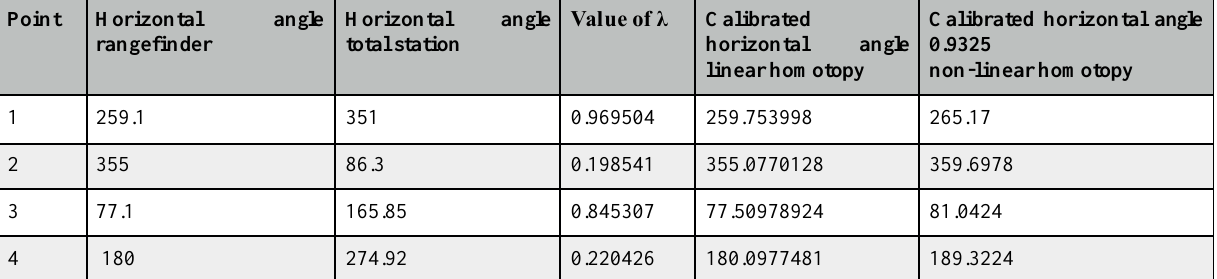
Table 8: Calibration of room 10 rangefinder horizontal angle measurements using total station horizontal angle measurements by homotopies and least